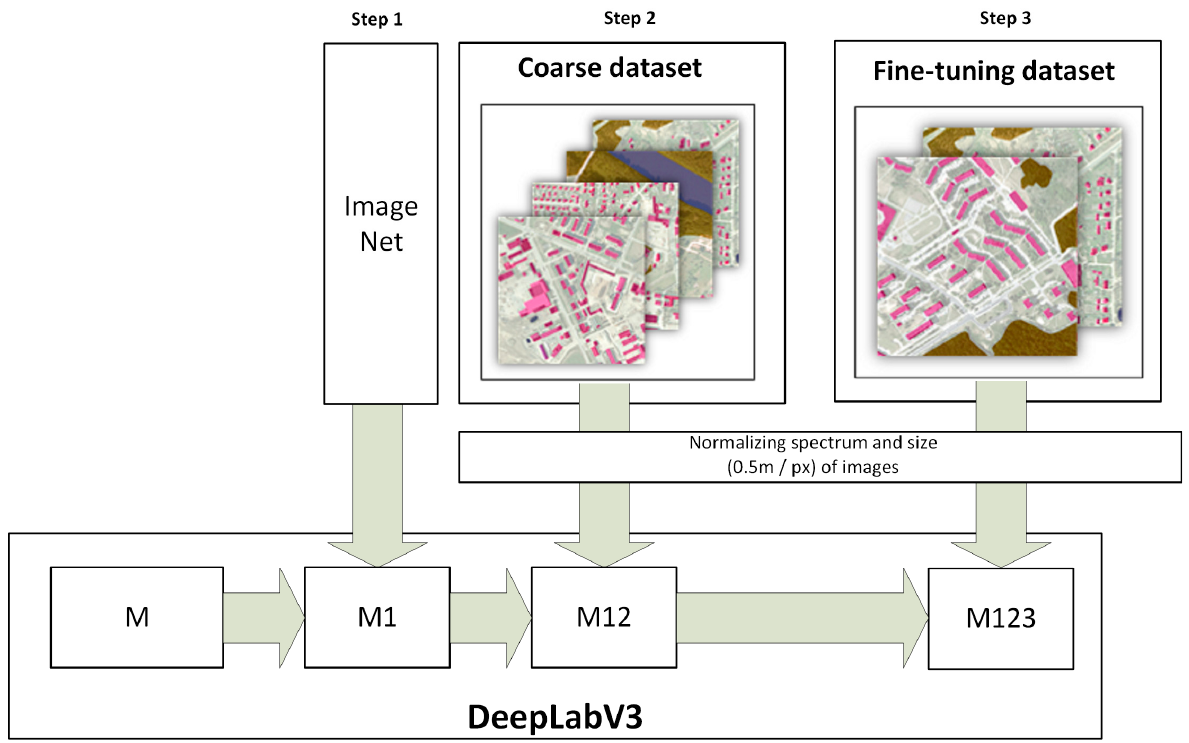
Figure 2. Scheme of ML model training steps.